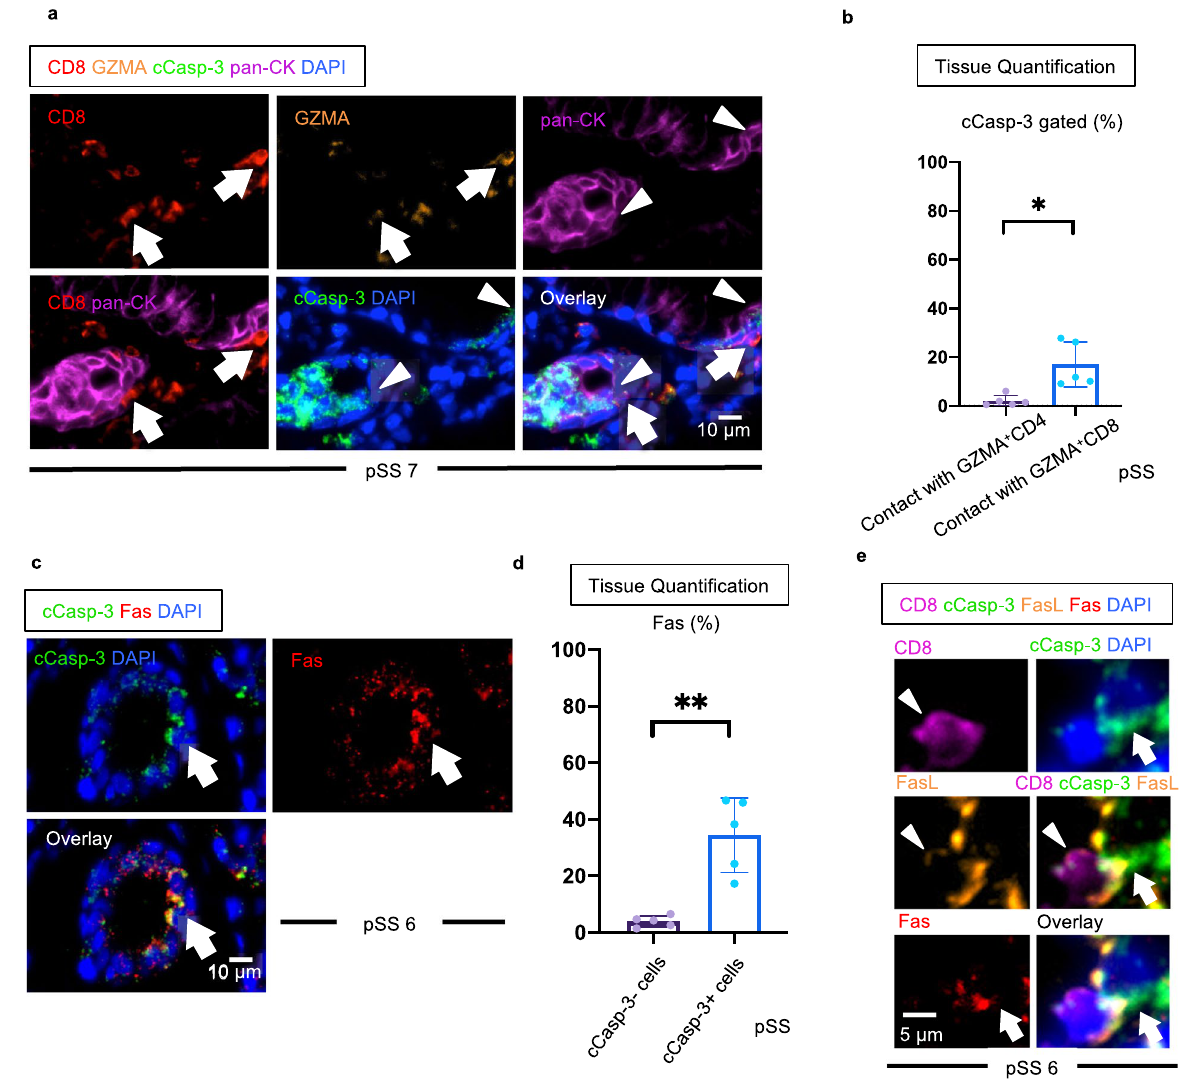
Figure 5. Epithelial cells expressing Fas are frequent targets of apoptosis in SS. ( a ) Representative multi-color immunofluorescence image showing GZMA (purple) expressing CD8 + CTLs (white arrows) in close proximity to cCasp-3 + epithelial cells (arrow heads). ( b ) Relative proportions of cCasp-3+ cells in contact with CD4 + or CD8+ T cells. Paired t test was used to calculate p-value. (n = 5). ( c ) Multi-color immunofluorescence images of cCasp-3 (green), Fas (red) and DAPI (blue) staining. White arrows show cells co-expressing cCasp-3 (green) and Fas (red). ( d ) Relative proportions of cCasp-3−/+ cells expressing Fas (n = 5). Paired t test used to calculate p-value. ( e ) Multi-color immunofluorescence images show a CD8+ (purple) and FasL+ (orange) expressing cell in contact with a cCasp-3 (green) and Fas (red) expressing cell in a pSS tissue. Error bars represent mean ± SEM. **p <